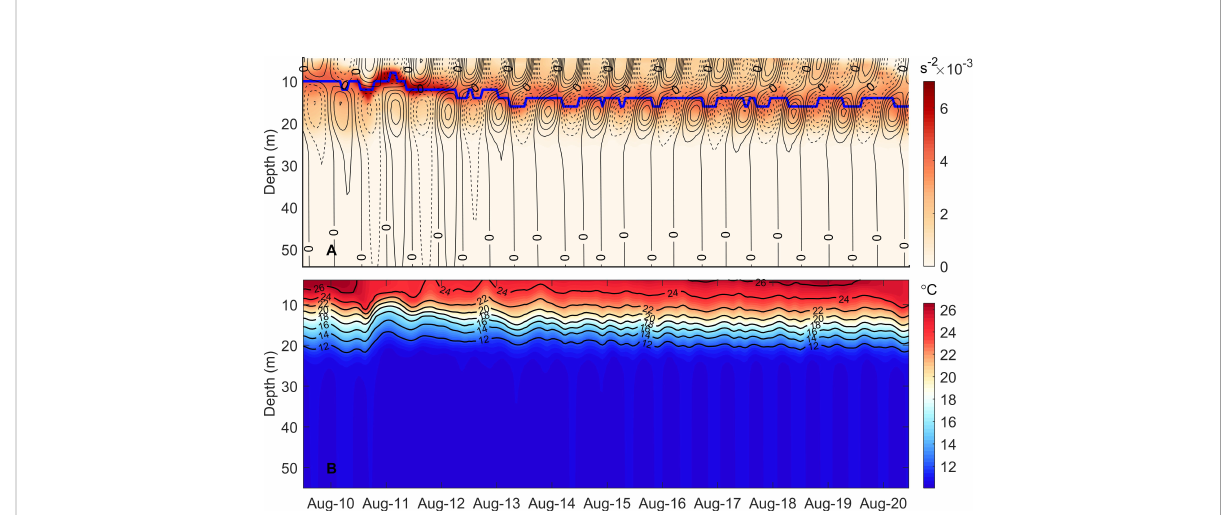
FIGURE 6 (A) N 2 (orange shading) and alongshelf near-inertial velocity (black contour lines) at the mooring site from ROMS. The black solid and dashed lines represent positive and negative values, respectively. Contour interval for velocity is 0.03m/s. The blue line represents the depth of the maximum strati fi cation. (B) The modelled temperature (°C) at the mooring site from